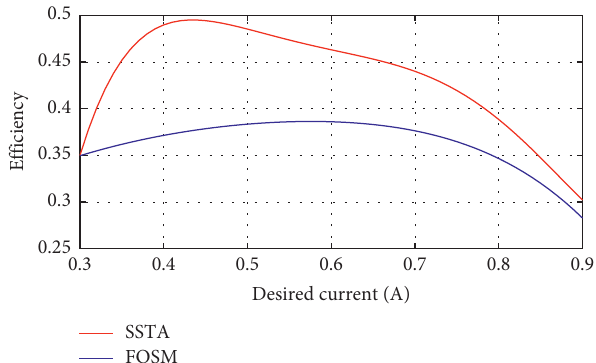
Figure 27: η − i ∗ characteristic curves of the SSTA and FOSM